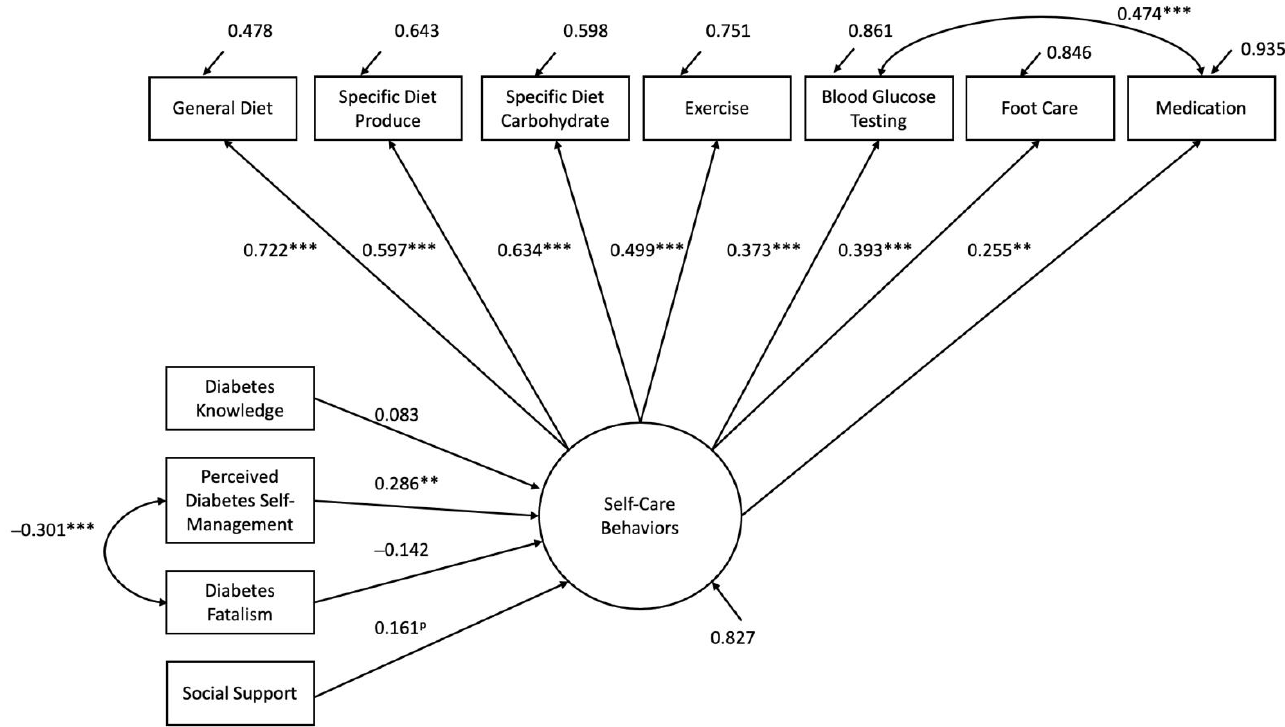
Figure 2. Structural model with parameter estimates for each path. Standardized solution: ** p < 0.01, *** p < 0.001, p indicates a p -value equal to 0.085. Only one correlation among exogenous variables is presented, although all were fit. See Table 1 for correlations.